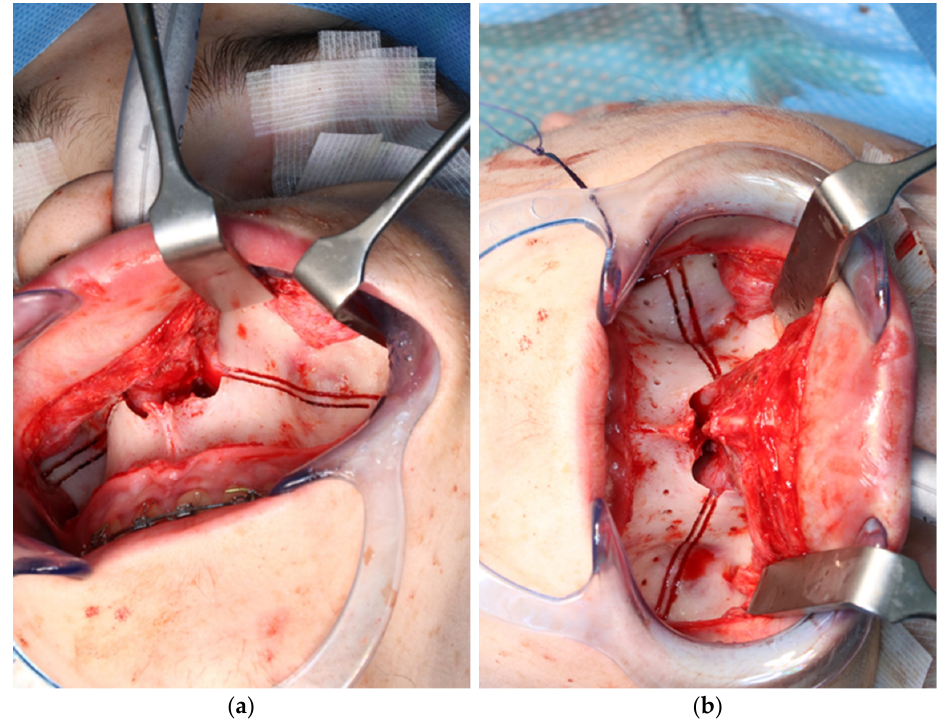
Figure 9. Use of the CARLO ® to mark the planned drill holes (( a ), black arrows) as well as after drill holes were created using a conventional rotating handpiece ( b ).